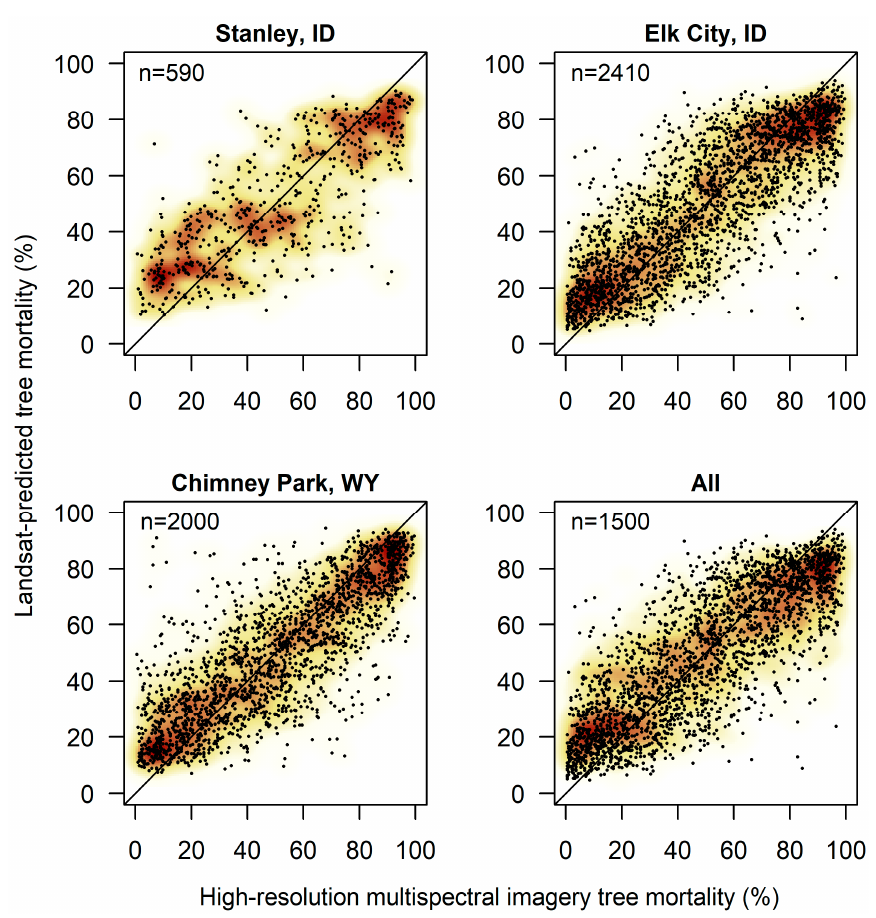
Figure 4. Percent tree mortality as observed by high-resolution multispectral imagery versus percent tree mortality as predicted by Landsat variables via cross-validated random forest models. High-resolution multispectral imagery for Stanley, Chimney Park, and Elk City was digital aerial orthophotography, QuickBird, and WorldView-2, respectively.